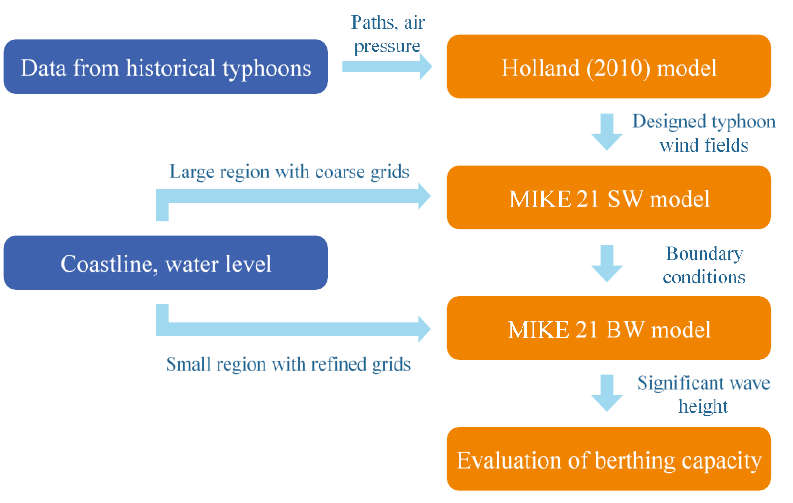
Figure 1. Flowchart of the present method.